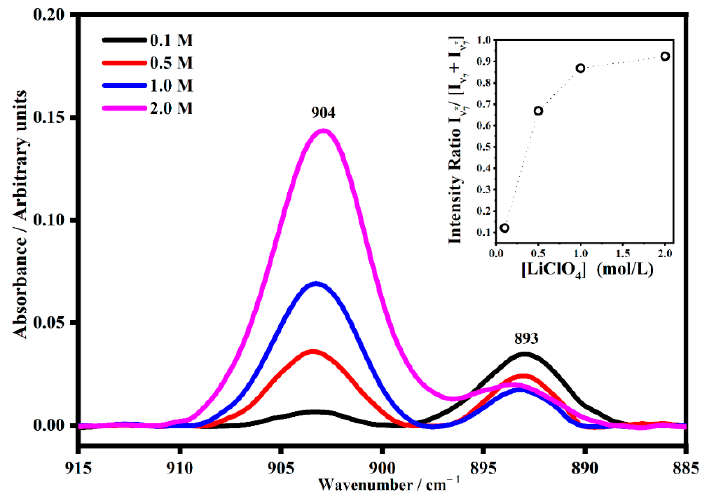
Figure 12. The IR band assigned to the skeletal ring breathing mode ν 7 (~893 cm − 1 ) of ethylene carbonate molecules and its satellite band at ν 7* (~904 cm − 1 ) in PMMA-Li-PC-EC gel polymer electrolyte at different salt concentrations: 0.1 M, 0.5 M, 1 M and 2 M. In the inset, the trend of the intensity ratio I ν 7* /[I ν 7 + I ν 7* ] as a function of the salt concentrations.